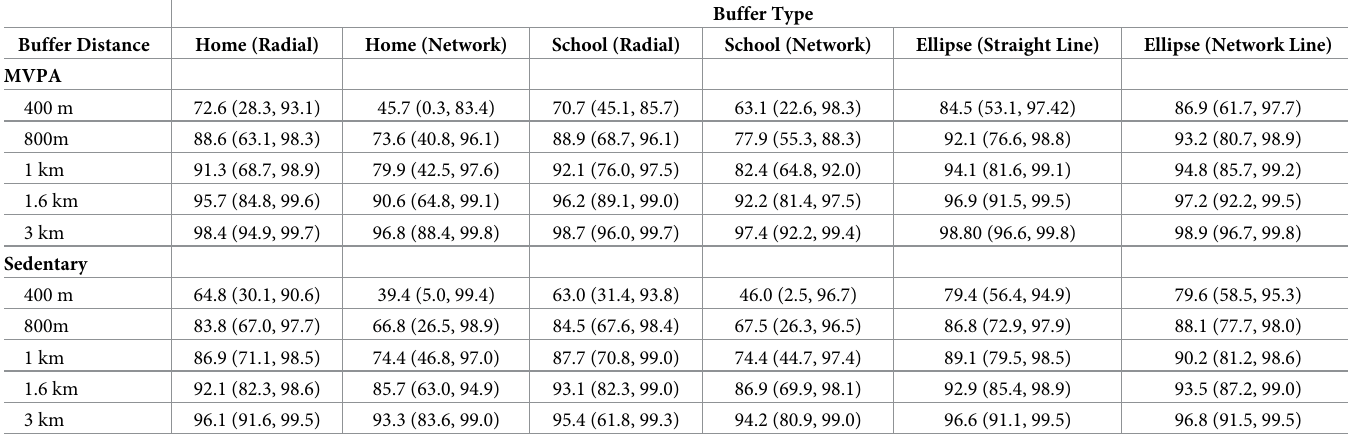
Table 3. Percentage of buffer unused by MVPA and sedentary space.